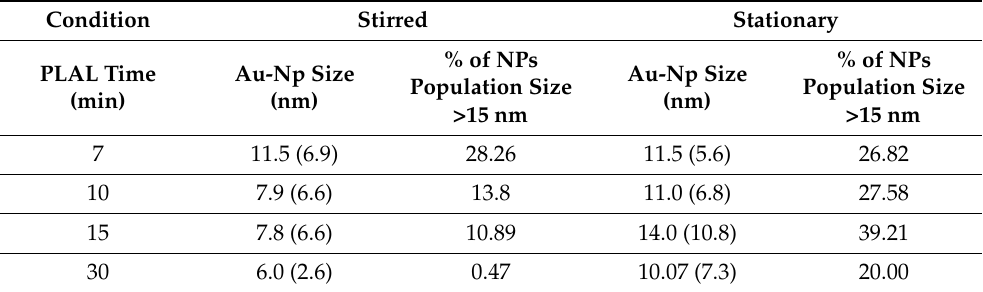
Table 4. Comparison of mean particles diameter for stirring and stationary tetrahydrofuran medium for four different times (retrieved with permission from reference